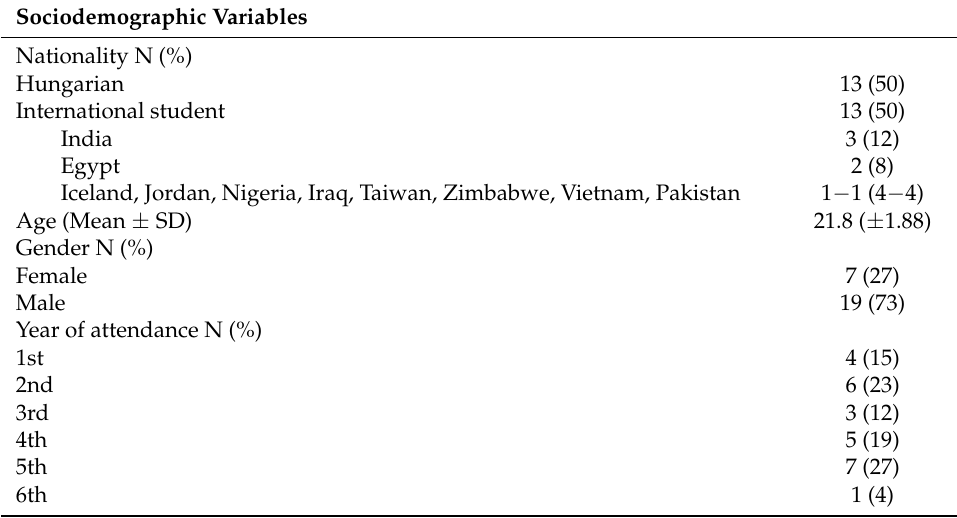
Table 1. Sociodemographic characteristics of the